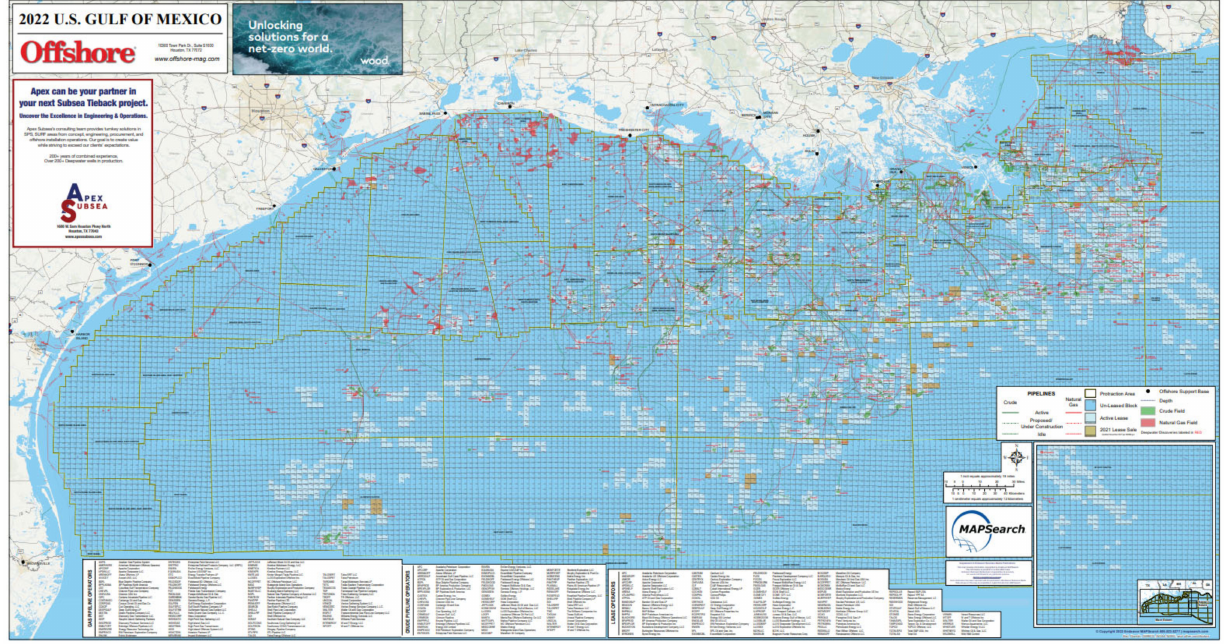
Figure A6. Map of breakdown of Application envelopes for deep-water platforms in the Gulf of Mexico {Illustrated by: Author 1—C.V.A.}.